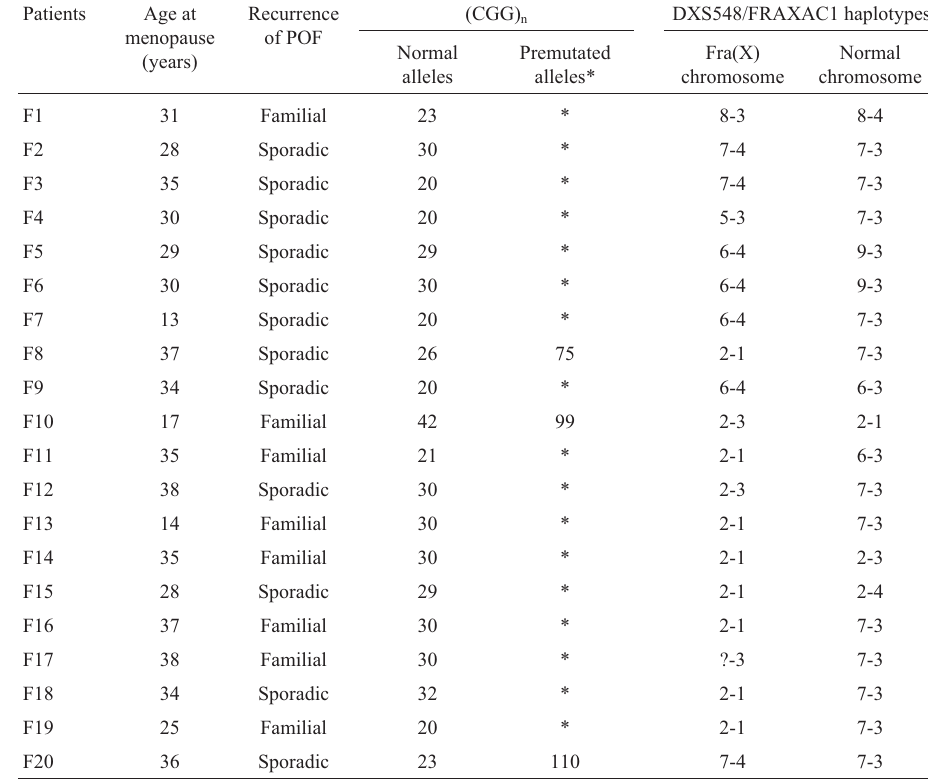
Table 2 - Premutation carriers with POF ascertained in fragile X families. Patients